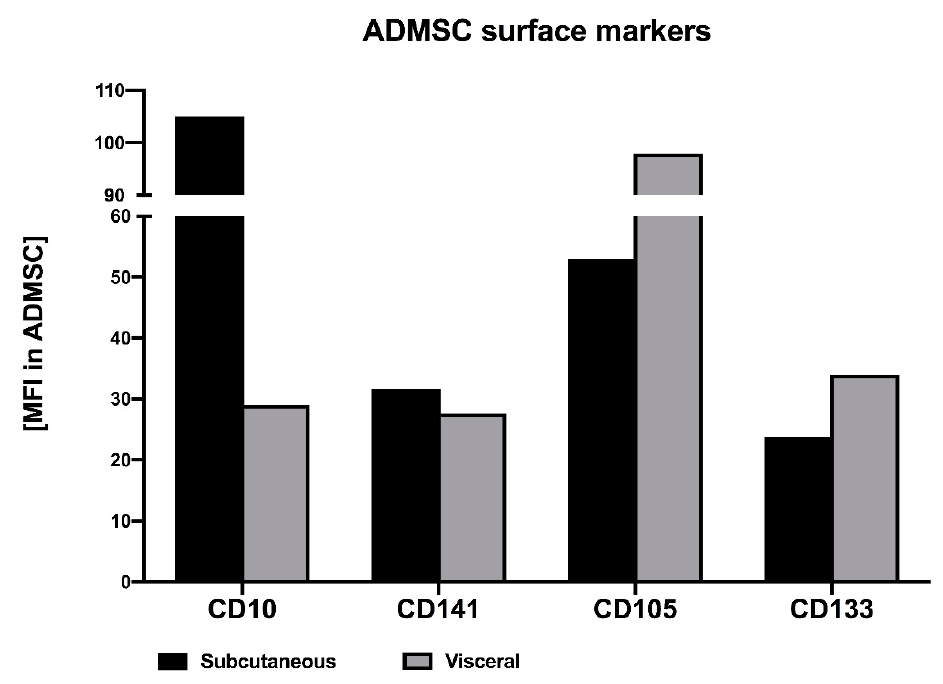
Figure 3. Mean fluorescent intensity (MFI) for CD10+, CD105+, CD133+ and CD141+ markers of ADMSCs obtained from subcutaneous and visceral fat depots.